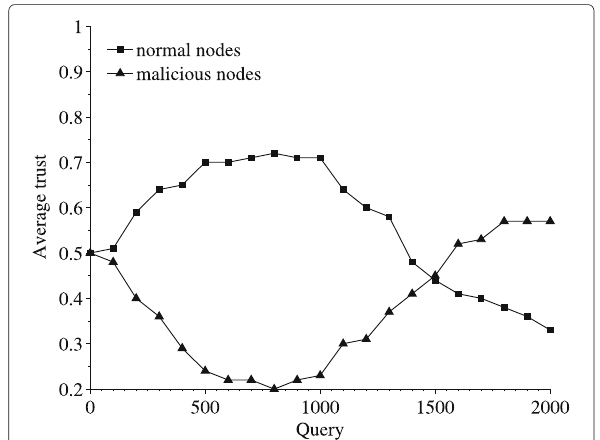
Fig. 8 Average trust with 5% increasing rate of compromised nodes in every 100 query in RFSN